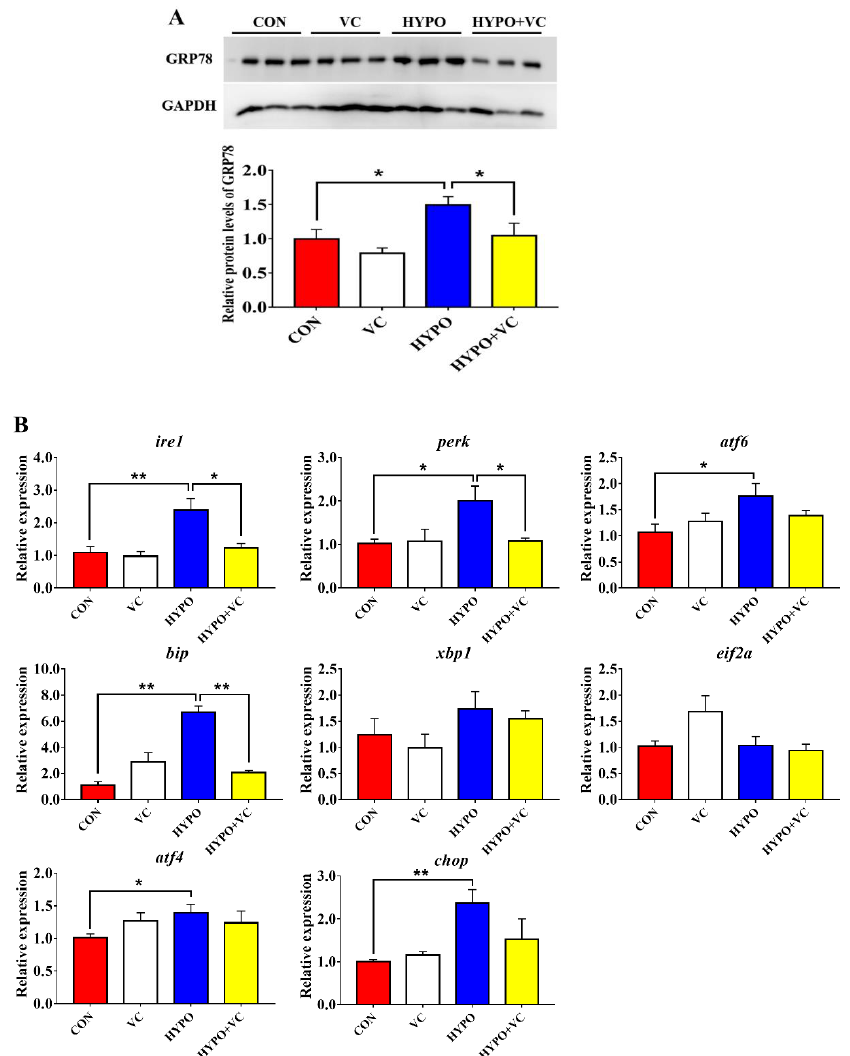
Figure 6. Changes in the expression levels of endoplasmic reticulum stress key protein, ( A ) and related genes ( B ) in the liver of gibel carp in normal and hypoxia groups after 56 days of feeding with VC. The * or ** at the top of the bar chart indicates significant differences between treatments; * indicates a significant difference ( p < 0.05), and ** indicates an extremely significant difference ( p < 0.01). All of the data are presented as the mean ± standard error (n = 6).